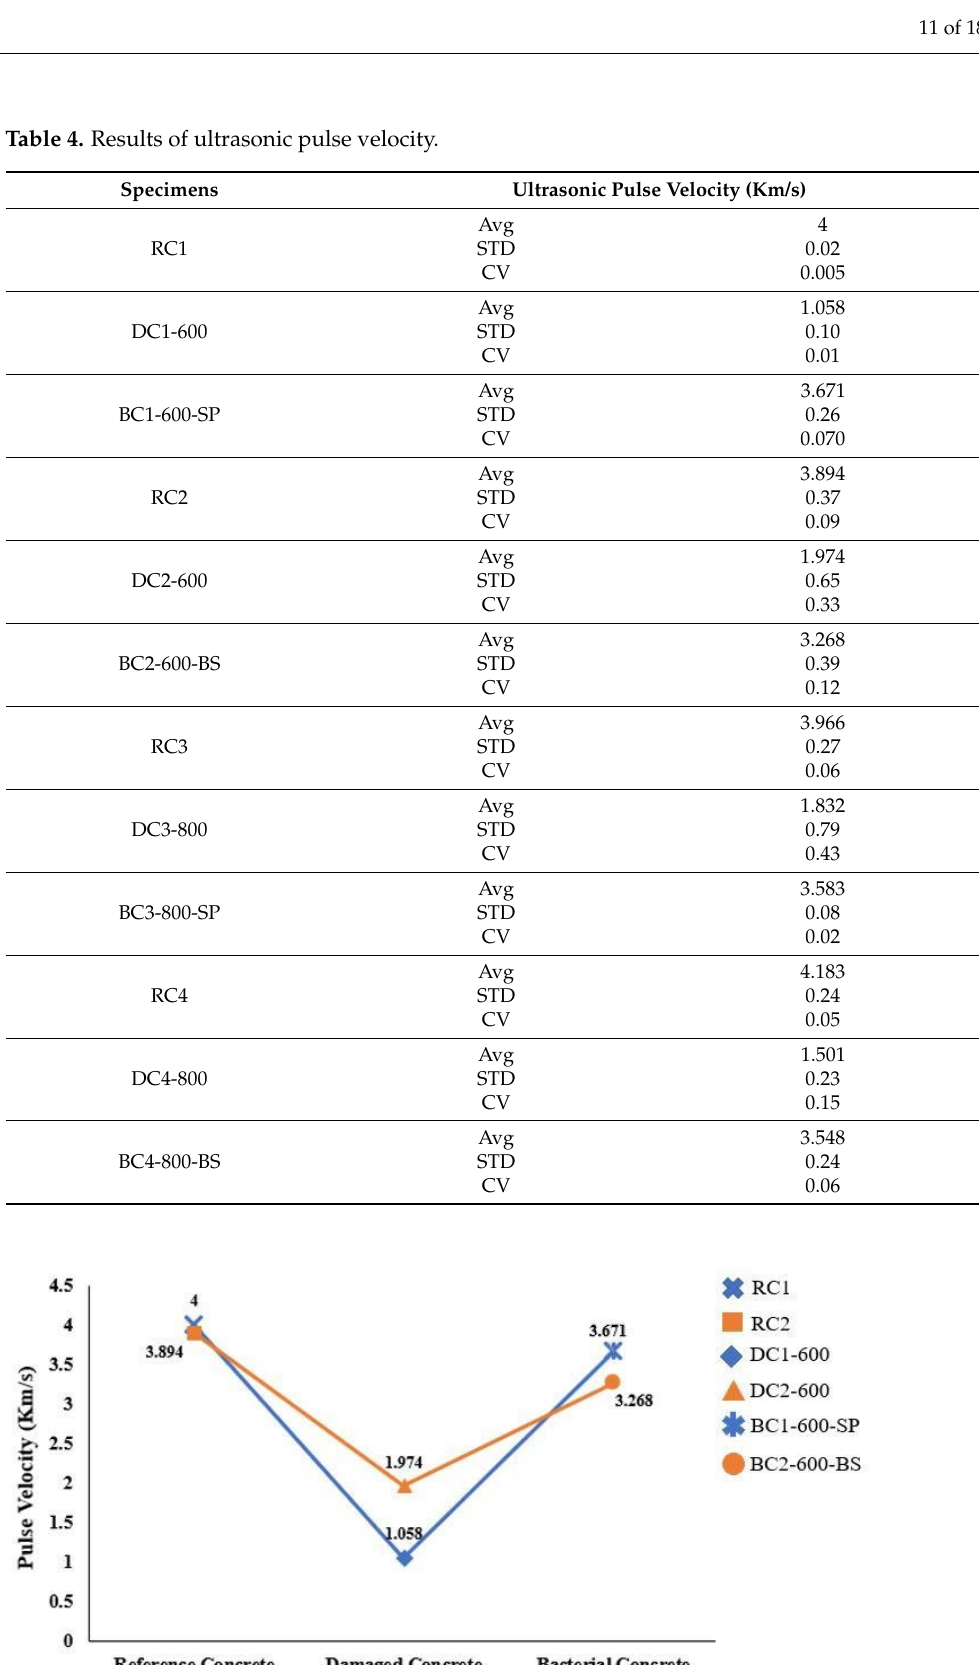
Figure 7. Comparing the ultrasonic pulse velocity results of the control specimens, damaged at 800 °C and repaired by type I and II bacteria. 3.3. Bulk Electrical Resistivity The bulk electrical resistivity test results, obtained from the average of two replica- tions on a cylindrical specimen, are given in Table 5. As shown in Figure 8, the electrical resistance of damaged specimens at 600 °C increased by about 67–121%. After the addition of bacteria and the filling of cracks and pores formed by heat, the electrical resistance for types, containing microbial organisms, decreased. The electrical resistance for the dam- aged specimens (at 600 °C), repaired by type I and II bacteria, reduced by about 22 and